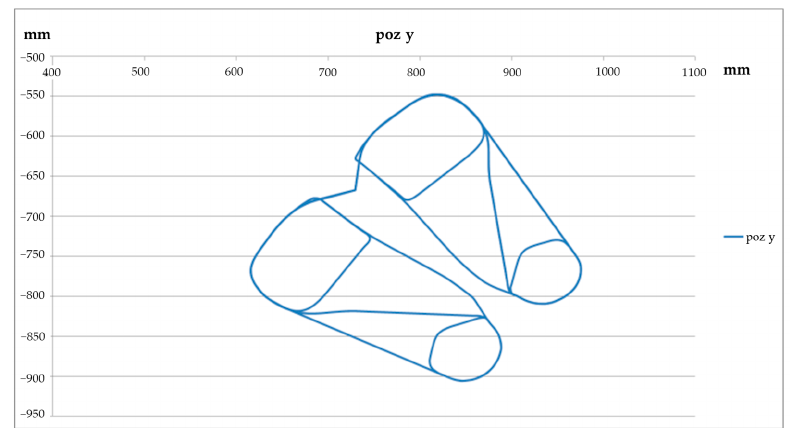
Figure 24. Complex winding dies force measurements. Electronics 2023 , 12 , x FOR PEER REVIEW